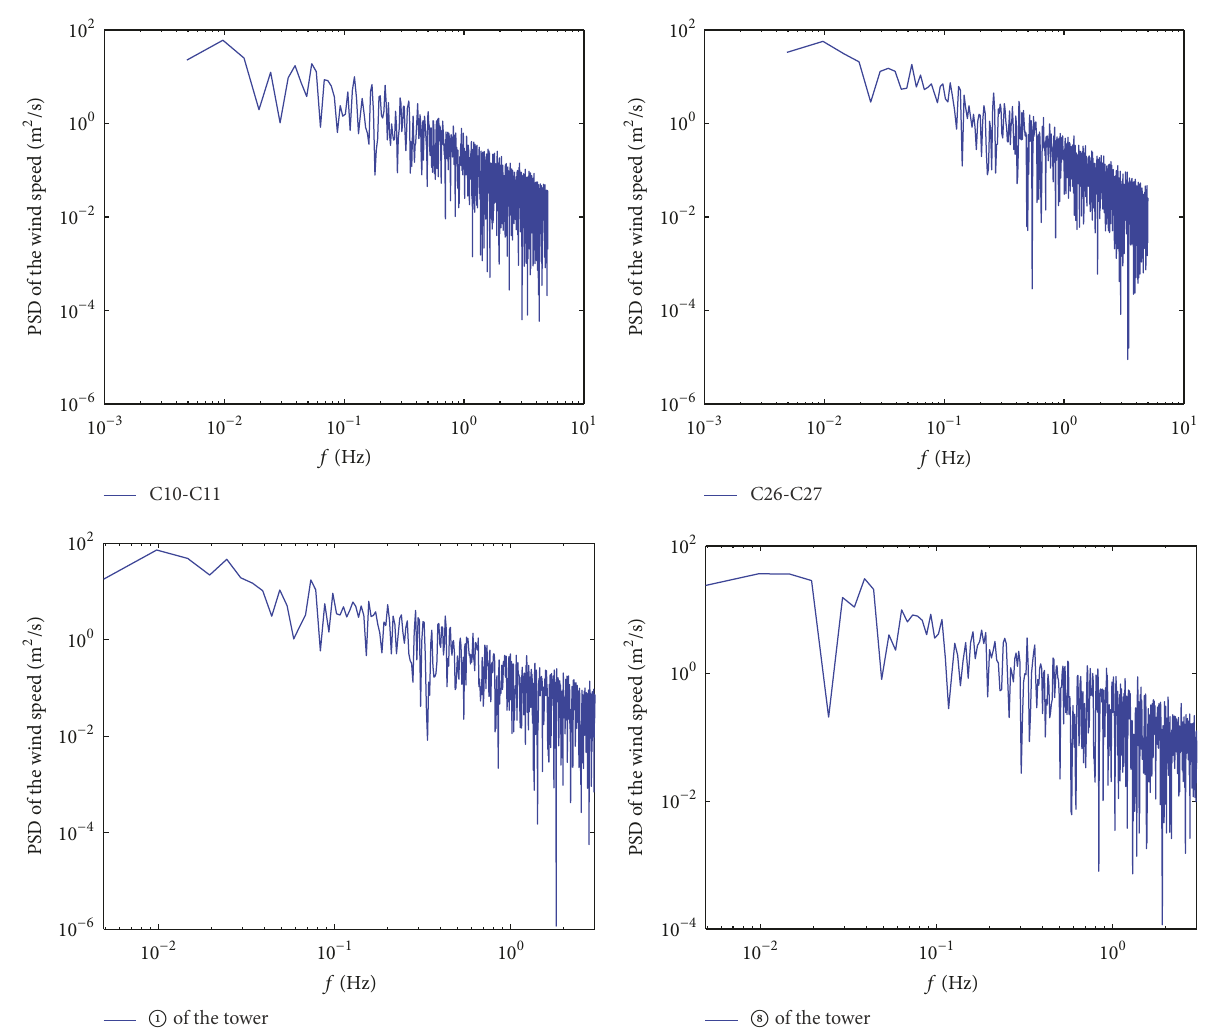
Figure 14: The simulated wind speed PSD on certain representative nodes on the transmission tower-line system.